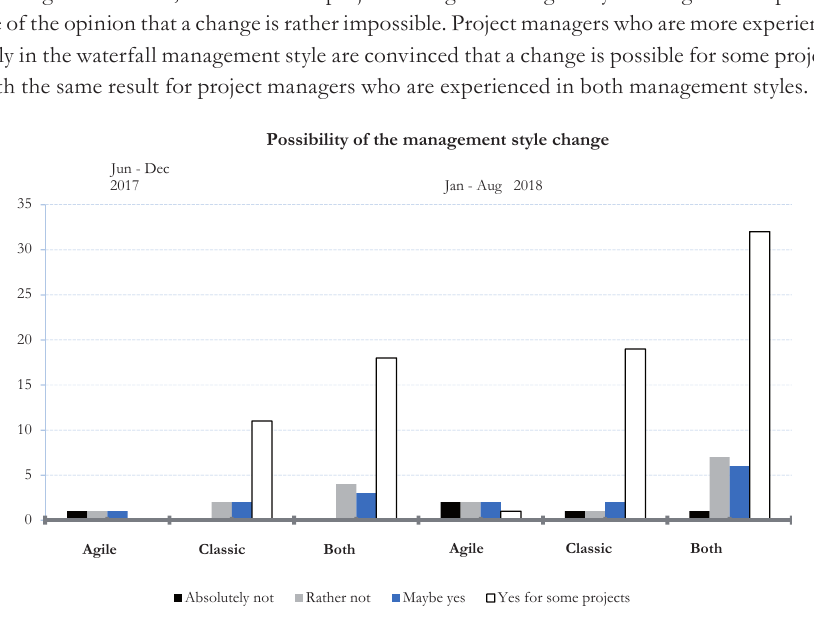
Fig. 1 – Bar graph for the corresponding data from 2017 and 2018. Source: own research using